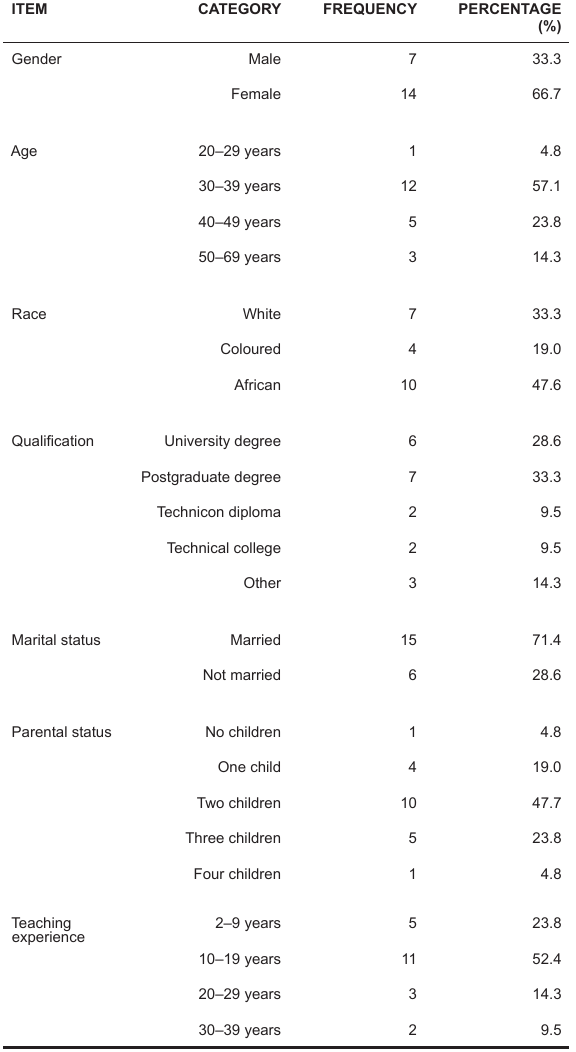
Table 1 Characteristics of the